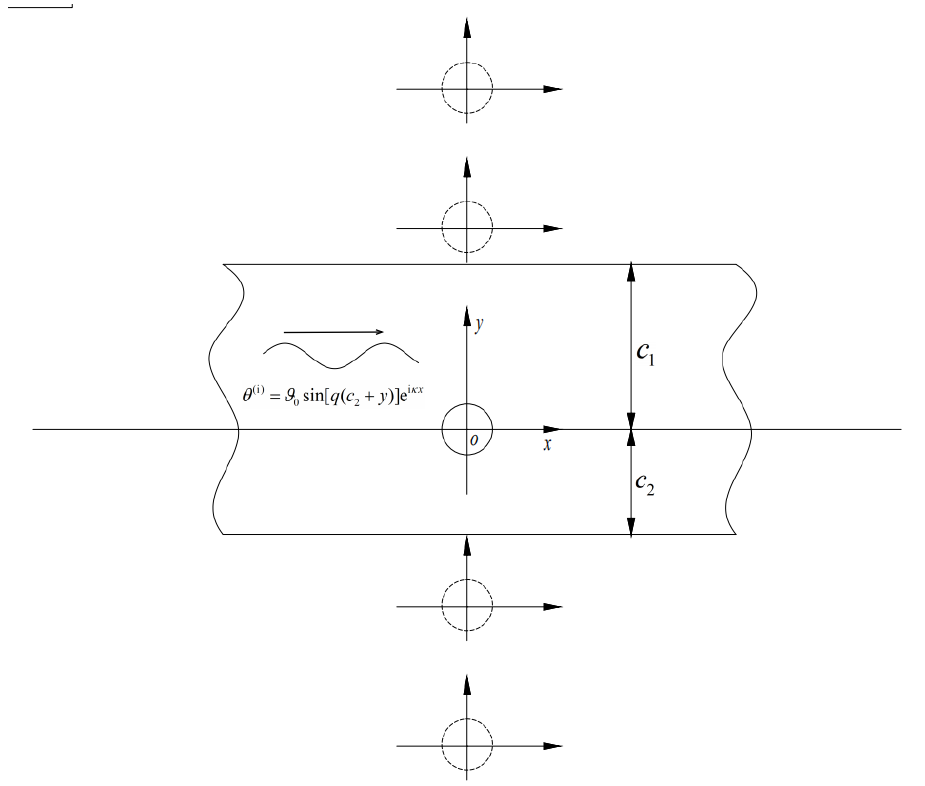
Figure 1. Diagram of Pt–Rh glass fiber leaky plate structure with a circular opening under pulse heating.